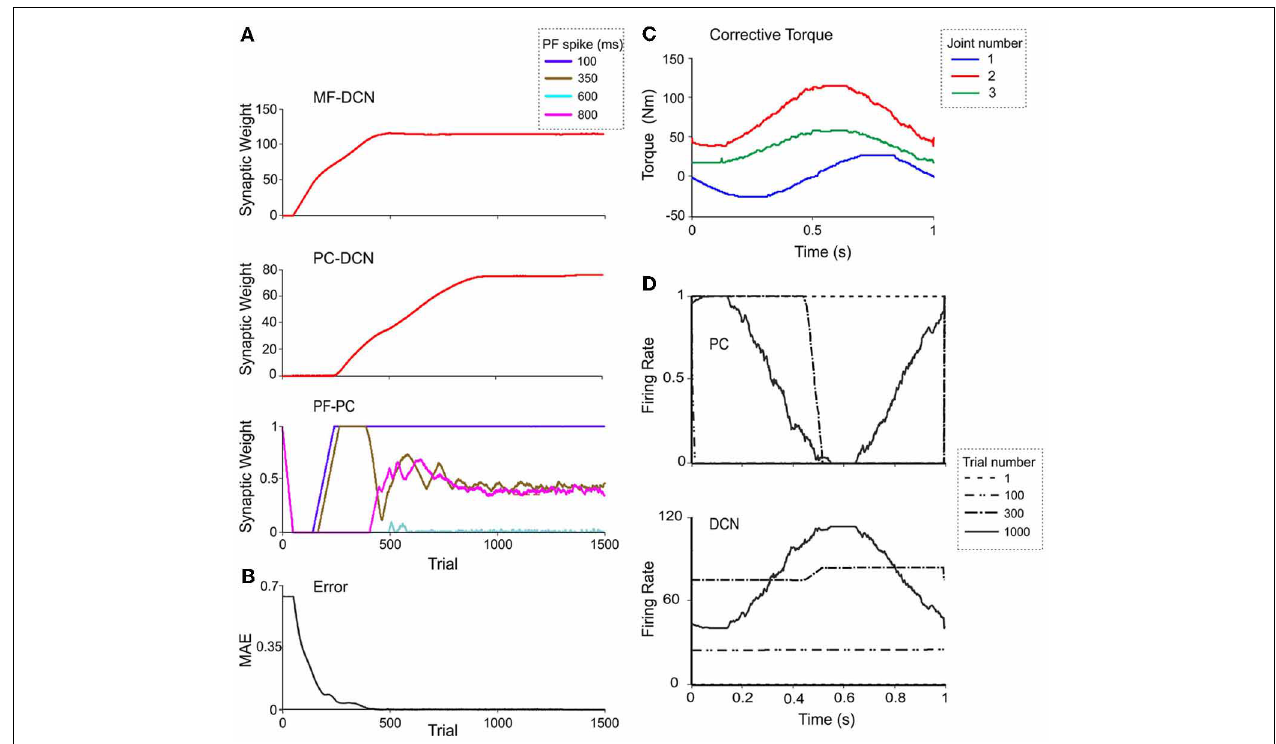
FIGURE 7 | Weight evolution in the cerebellar model with multiple plasticity mechanisms. Simulations were carried out using all the plasticity mechanisms (PF-PC, MF-DCN, and PC-DCN) for manipulation of a 10-kg external payload during 1500 trials. Initial synaptic weights allowed accurate movement of the arm without manipulation of any object (0-kg external payload). (A) Evolution of synaptic weights at MF-DCN (top) , PC-DCN (middle) and PF-PC (bottom) connections related to joint 2 agonist muscle. In PF-PC synapses, four different PFs that become active 100ms (purple) , 350ms